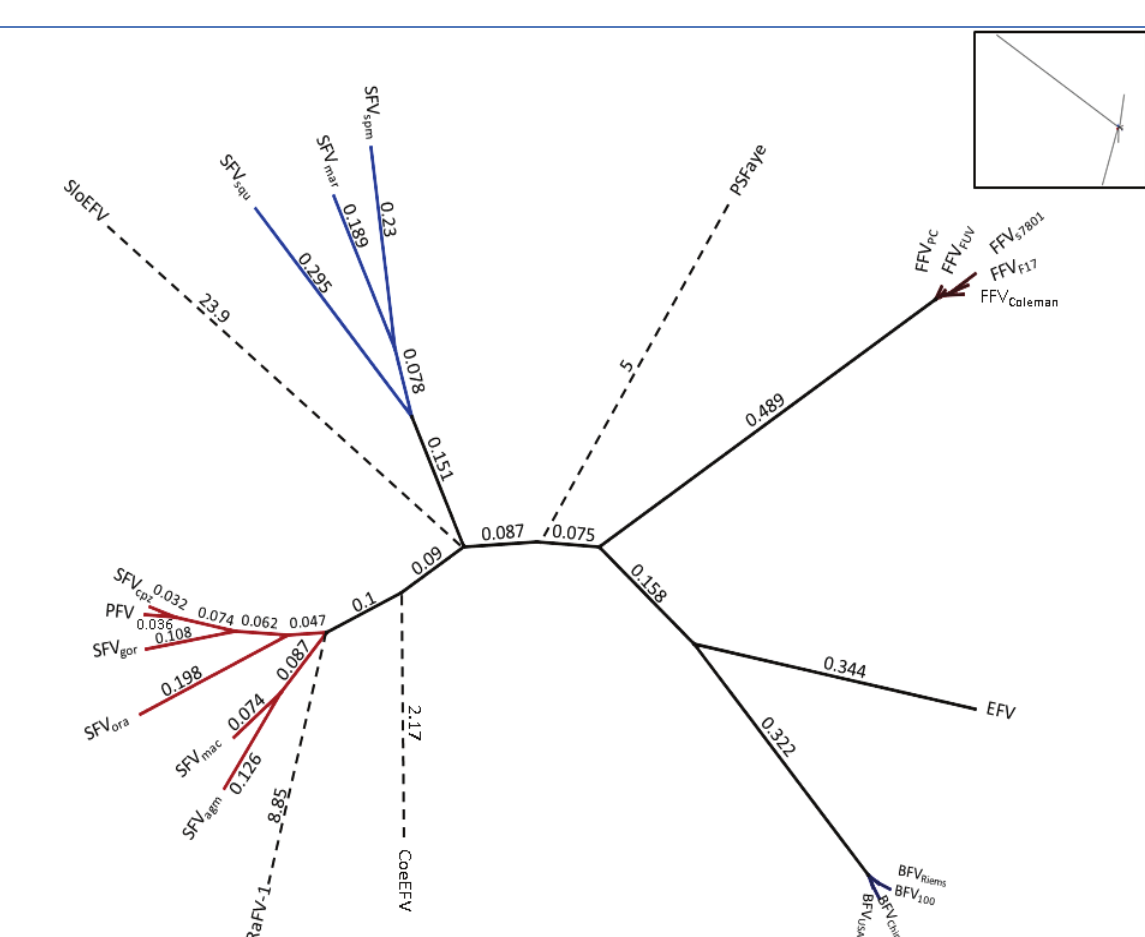
Figure 3. Unrooted phylogenetic tree of the complete Pol protein sequence from FV genomes listed in Table 2: For RaFV-1 and PSFVaye the available amino acid sequences were shorter, 475 and 733 aas respectively. Amino acid alignment for subsequent tree analysis was done using a global alignment with a Blosum62 matrix [44]. The phylogenetic tree was computed, using PHYML combined with the LG matrix and bootstrapping (1,000 replicates). The tree design was transformed proportional in order to display the high substitutions per site of RaFV-1, SloEFV, PSFVaye and CoeEFV. The numbers atop the branches display the substitutions per site. The insert in the right upper corner, displays the initial computed tree as an original overview for the branch lengths which are transformed for visibility’s sake for the endogenous CoeEFV, SloEFV, pSFaye and RaFV-1 (dashed lines). Viral designations are given in Table 1. Accession numbers for most FVs are given in Table 2. The missing accession numbers are not available and sequences used can be found in the references for endogenous FVs: RaFV-1 (JQ814855.1), PSFVaye [15], CoeEFV [13], SloEFV